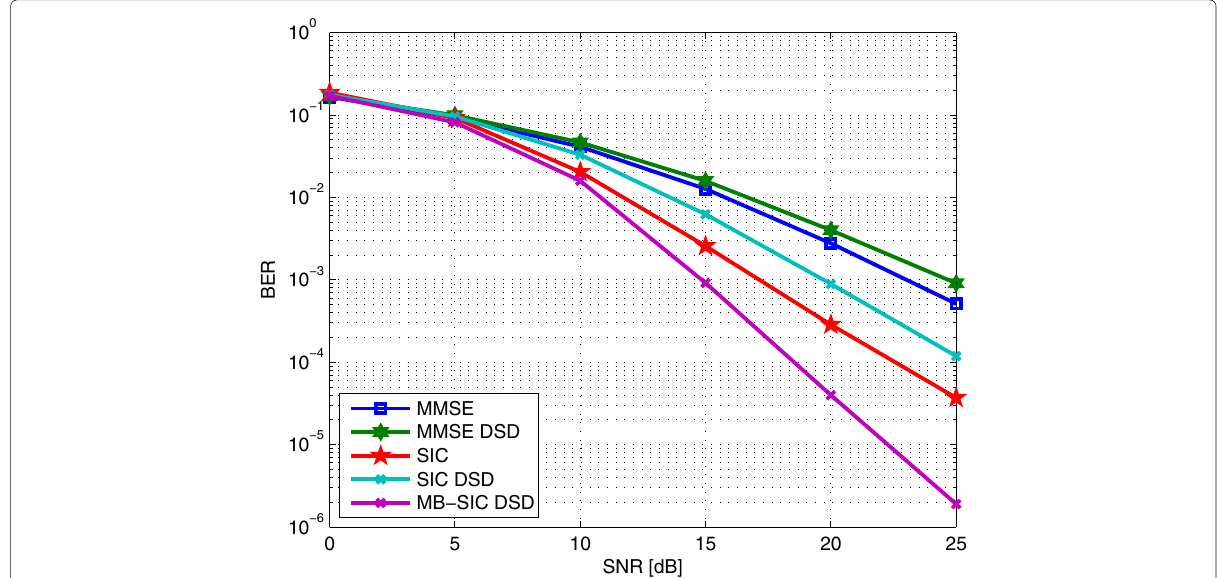
= 3 transmit antennas per user and N k , n